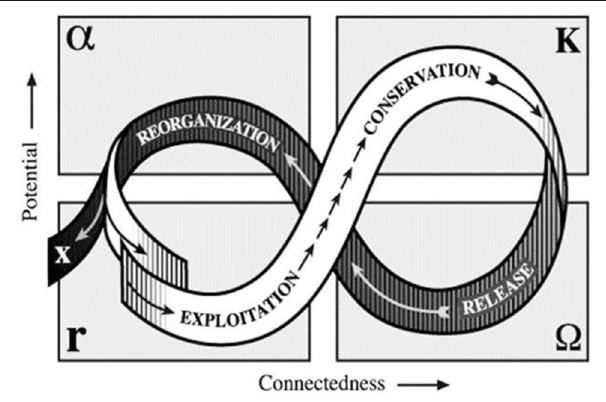
FIGURE 4 | Representation of Holling’s adaptive cycle (From Panarchy edited by Gunderson and Holling, 2002. Copyright © 2002 Island Press. Reproduced by permission of Island Press, Washington,